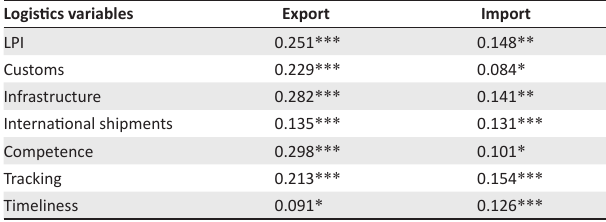
TABLE 2: Logistics coefficients of EU-26 in